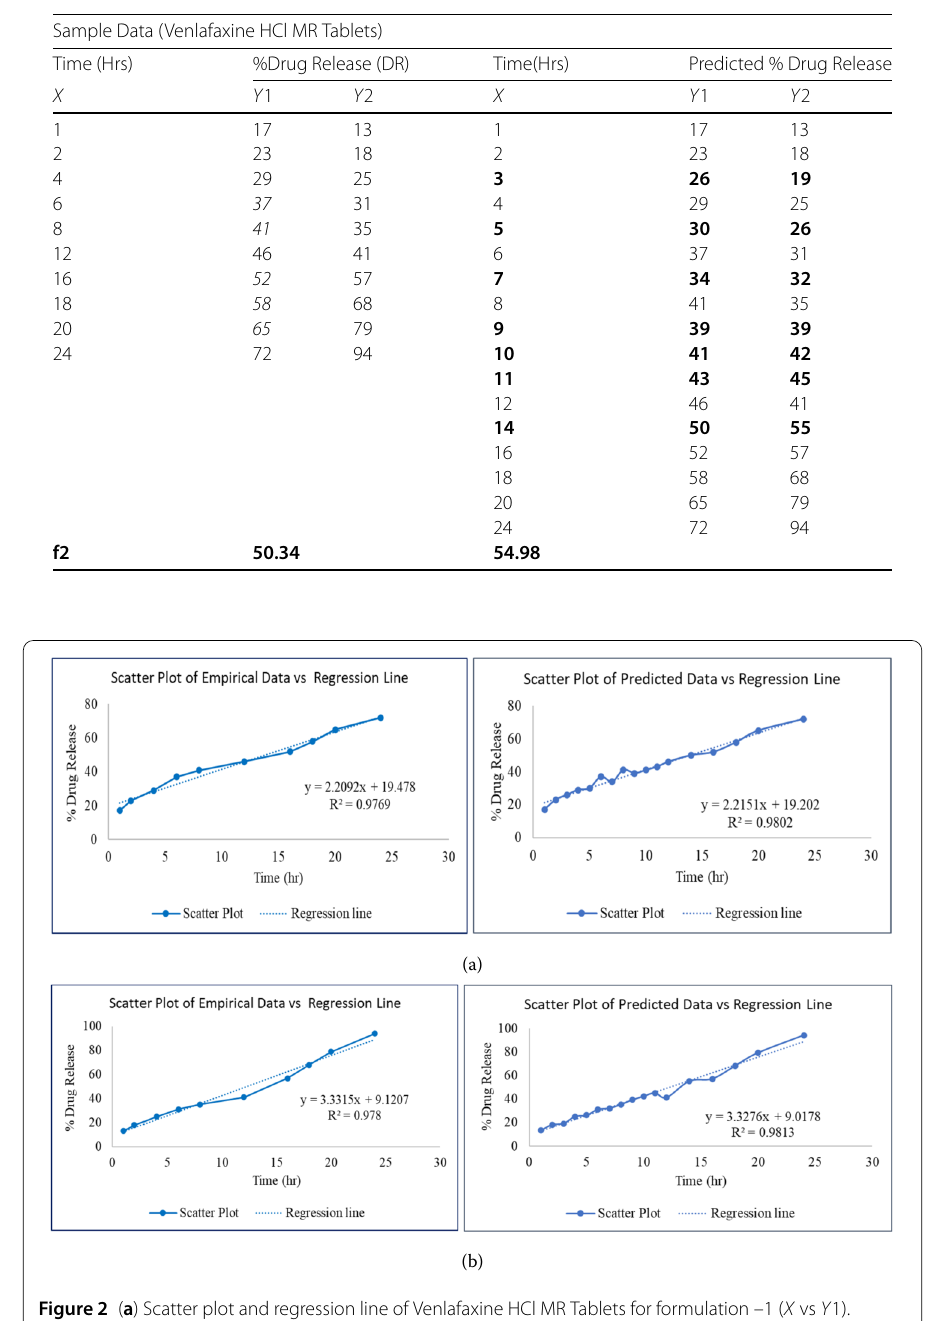
from empirical data. Figure 2(a) represents scatter plot and regression line of Venlafaxine HCl MR Tablets for formulation –1 ( X vs Y 1) and Fig. 2(b) represents scatter plot and regression line of Venlafaxine HCI MR Tablets for formulation –2 ( X vs Y 2). Table 5 represents comparison of two drug release profiles of Lurasidone IR Tablets; similarity factor f 2 is measured between two drug products and improvement is